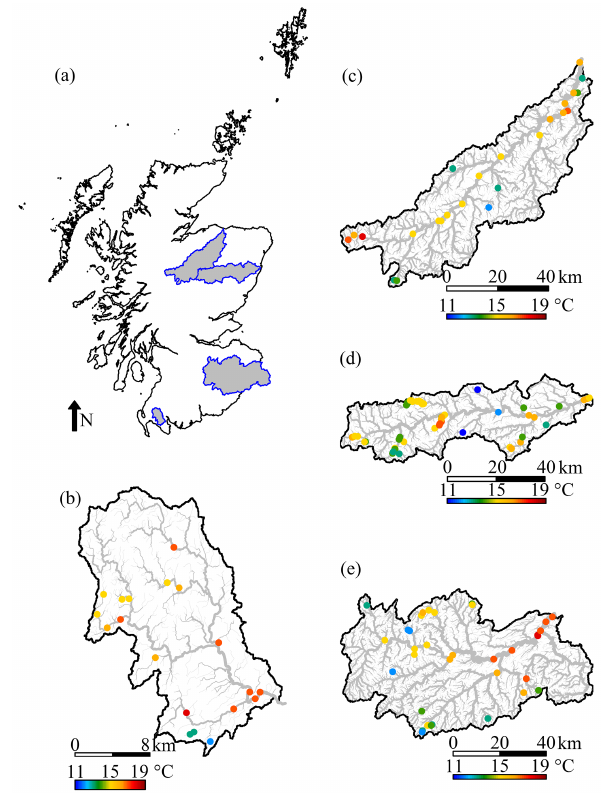
Figure 1. Study catchments and spatial patterns of T w gust 2015 (Jackson et al., 2017a). (a) Catchment positions in Scot- land, (b) the River Bladnoch catchment, (c) River Spey catchment, (d) River Dee catchment and (e) River Tweed catchment. Some fea- tures of this map are based on digital spatial data licensed from the Centre for Ecology & Hydrology, © NERC (CEH) and con- tains Ordnance Survey data © Crown copyright and database right (2016). Catchment boundaries are from SEPA